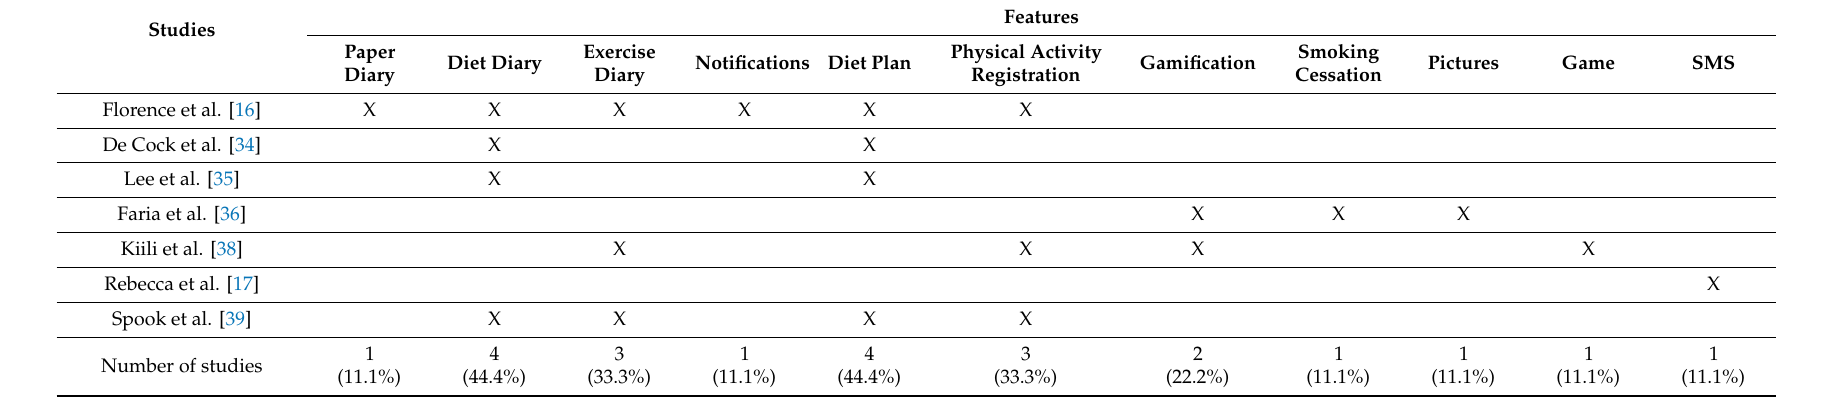
Table 3. Distribution of the functionalities of the mobile applications explored in each